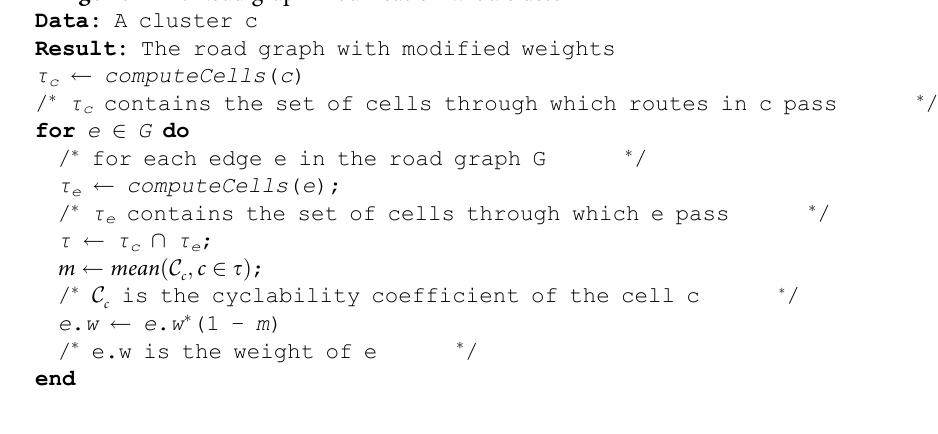
Algorithm 1: Road graph modification wrt a